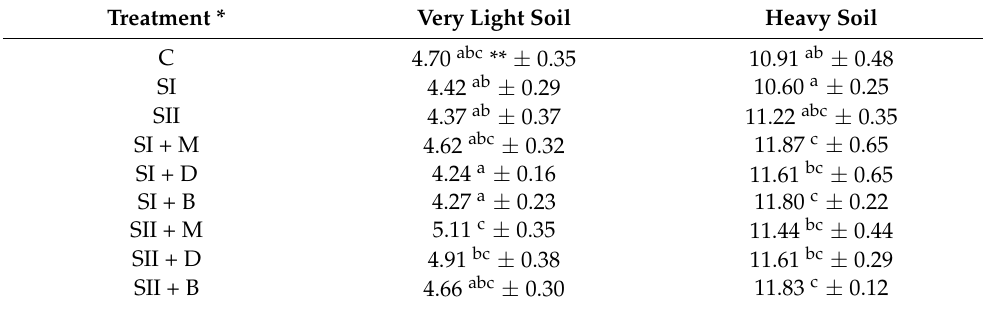
Table 5. Total organic carbon content in very light and heavy soil after 240 days of incubation experiment (g C/kg d.m. ±